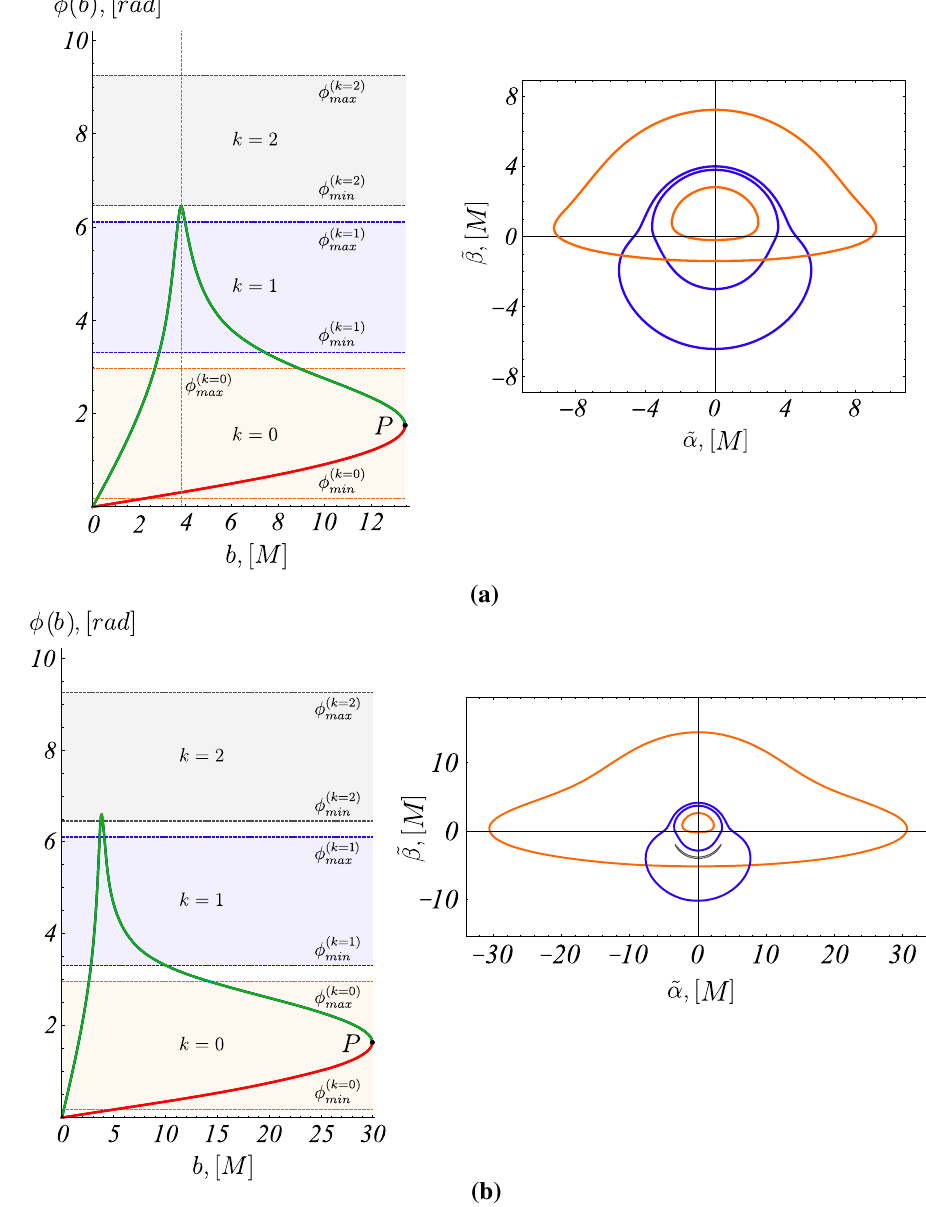
Fig. 10 Image formation diagrams and the corresponding observable images for the circular orbits located at r = 13 . 56 M ( a ) and r = 30 M ( b ) in the spacetime of the strongly naked singularity with γ = 0 .